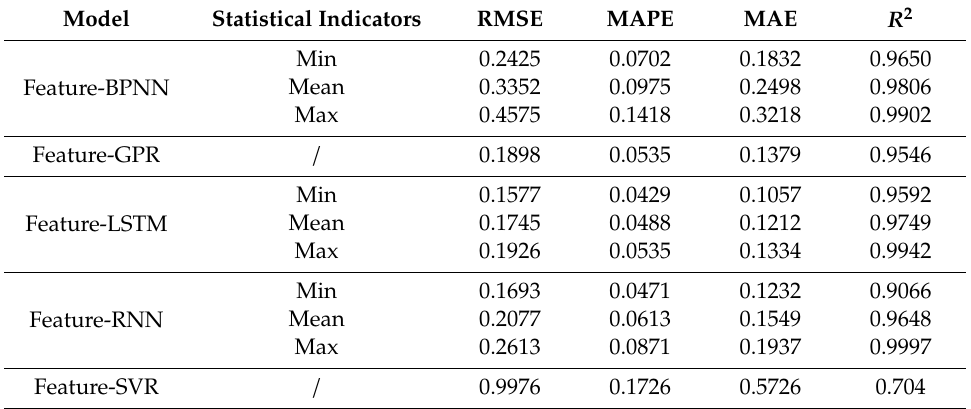
Table 5. Evaluation of prediction results using meteorological characteristics model.